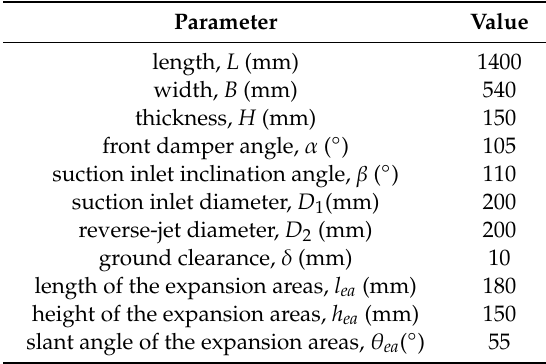
Figure 2. Vacuum-blowing cleaning system. Table 1. Physical Model Parameters of Computational Domain.